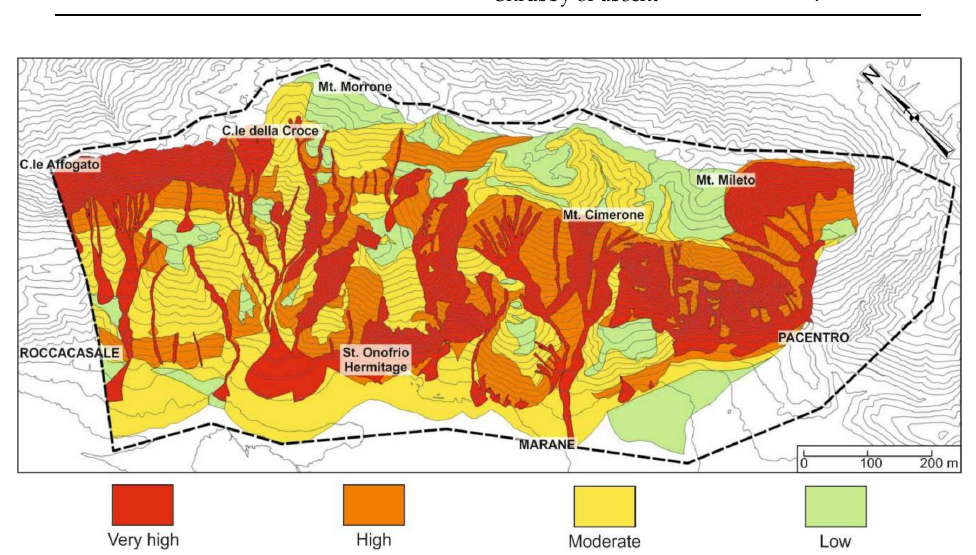
Figure 18. Post-wildfire hazard map. The black dashed box indicates the location of the study